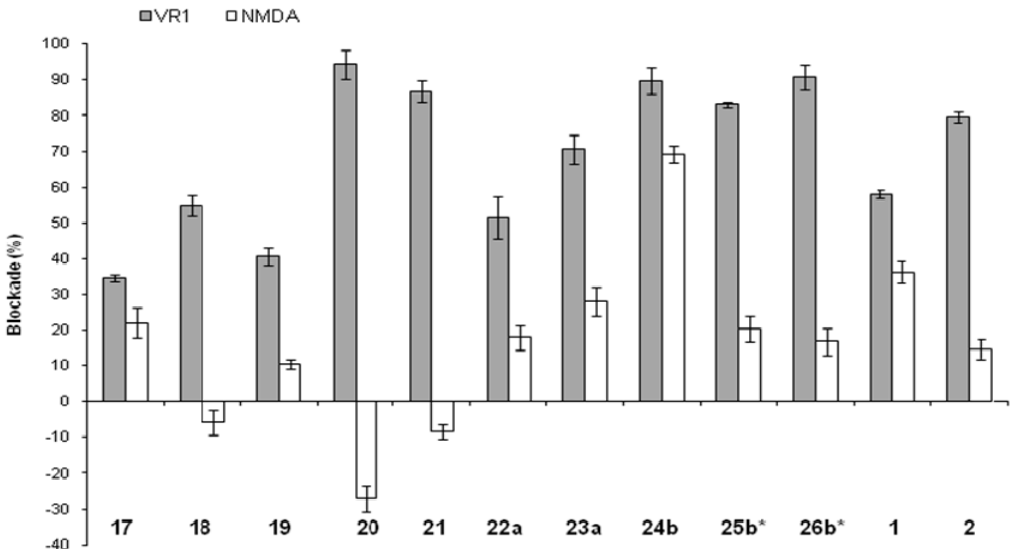
Figure 1. Blockage of TRPV1 and NMDA activity by compounds 17-26 . Each bar represents the mean ± SEM, n =